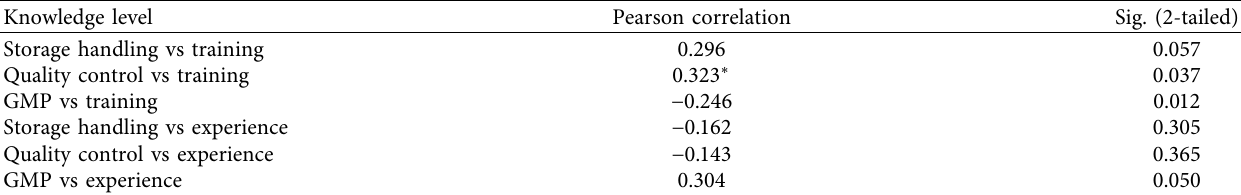
Table 6: Effects of training and experience on producers’ knowledge of food safety.